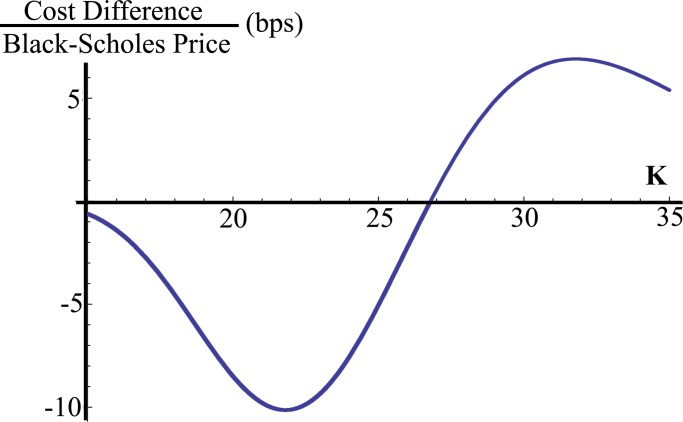
Option price difference for different strikes.Difference in option prices (proposed vs. Black-Scholes) expressed as a percent of the Black-Scholes price for different strikes K, where τ = 0.5 years, σ = 0.265 years−1/2, γ = 0.068 years−1/3 and r = 0.035 years−1.